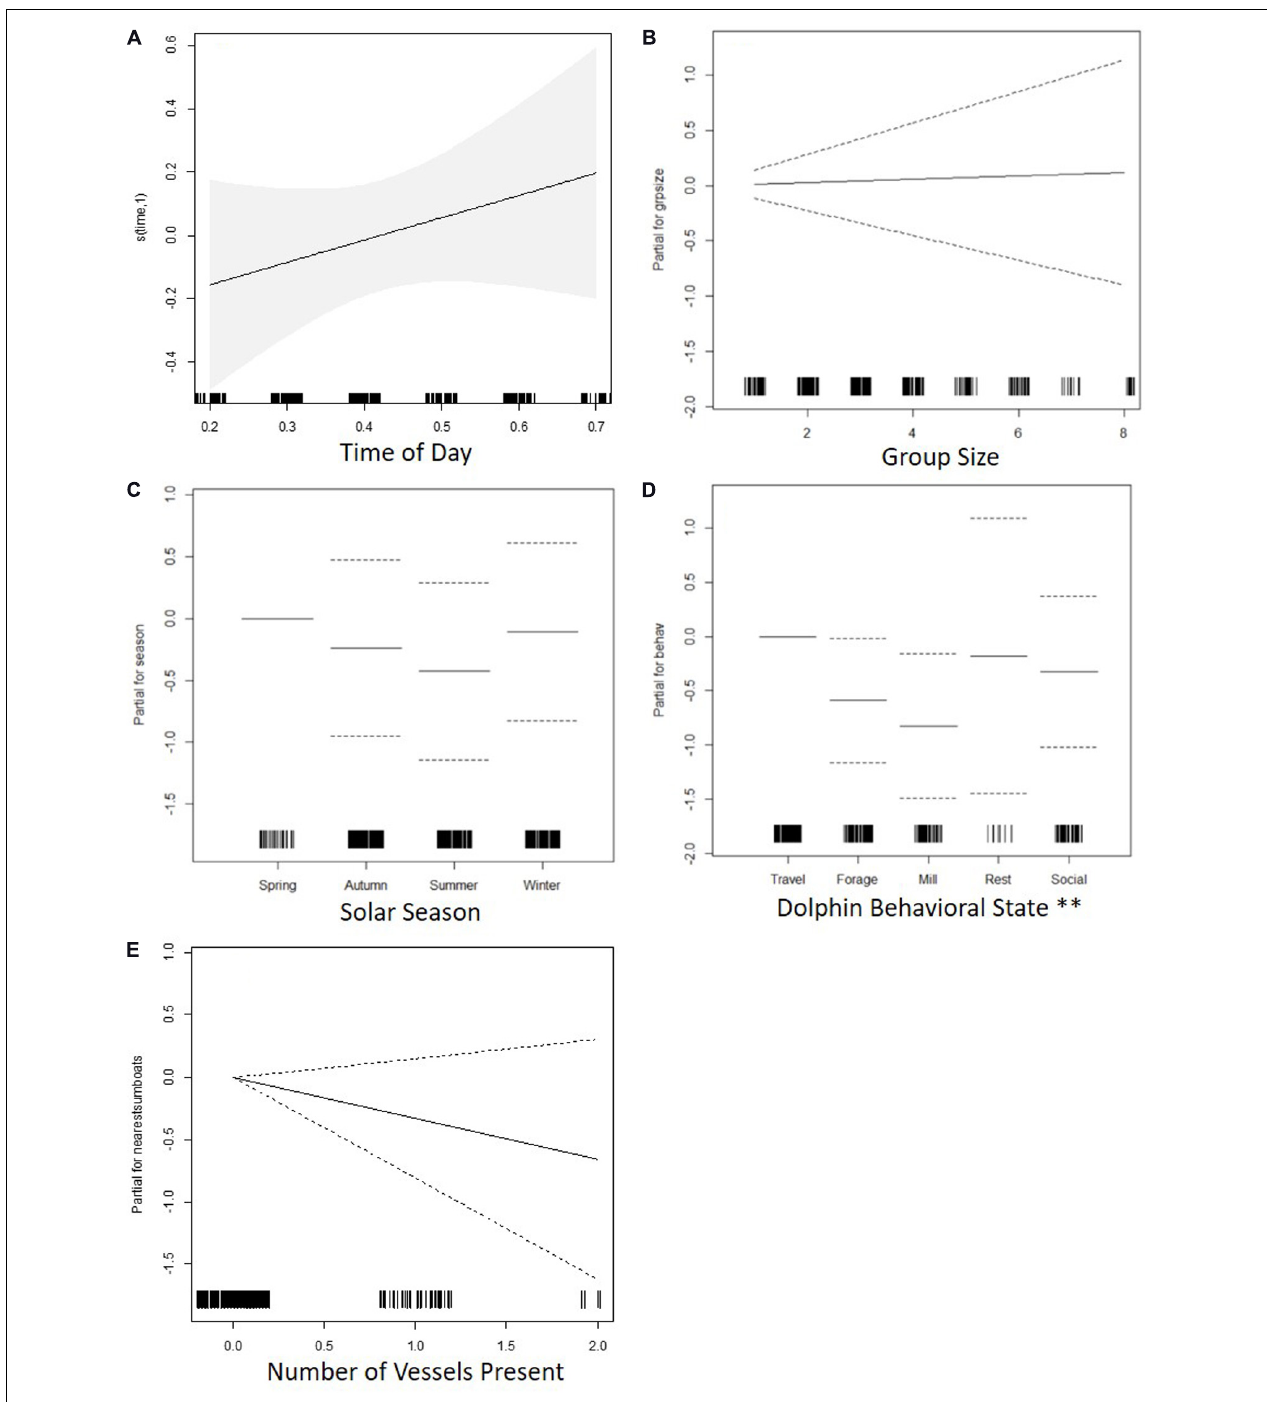
FIGURE 6 | Charts for the partial contribution of individual explanatory variables in the fitted GAM for linearity. Charts include: (A) time of day, (B) dolphin group size, (C) solar season, (D) dolphin behavioral state, and (E) number of vessels present. The rugplot along the x -axis indicates the density of observations for each factor. On the y -axis, values > 0 indicate a positive correlation with linearity, values < 0 indicate a negative correlation, and a value of 0 indicates no effect. Signif. codes: “**”